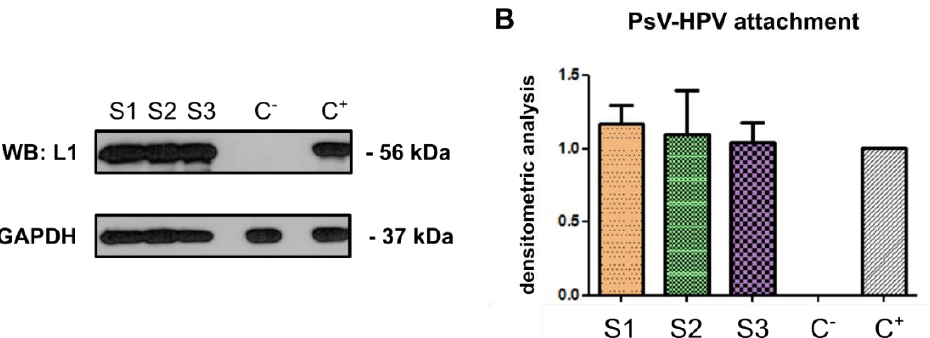
Figure 4. Effect of C. majus latex (S1), protein fraction (S2), and alkaloid-rich fraction (S3) on the attachment of HPV pseudovirions to the surface of HaCaT cells. HPV pseudoviral particles were applied to HaCaT cells that had previously been incubated with crude C. majus latex, alkaloid-rich fraction, or protein fraction. The amount of pseudoviral particles bound to the cells was then determined by Western blot and L1-specific antibody. ( A ) Representative Western blot result after immunodetection. S1—treatment with crude latex, S2—treatment with protein fraction, S3—treatment with alkaloid-rich fraction, C − —sample without PsV-HPVs, C + —untreated cells. ( A ) Clear signal for all tested samples indicates the lack of influence of the crude C. majus latex, alkaloid-rich fraction, and protein fraction on the stability of the PsV-HPV L1 capsid proteins. ( B ) Densitometric measurement of the signals obtained on the film after immunodetection, normalized to the signal for GAPDH.